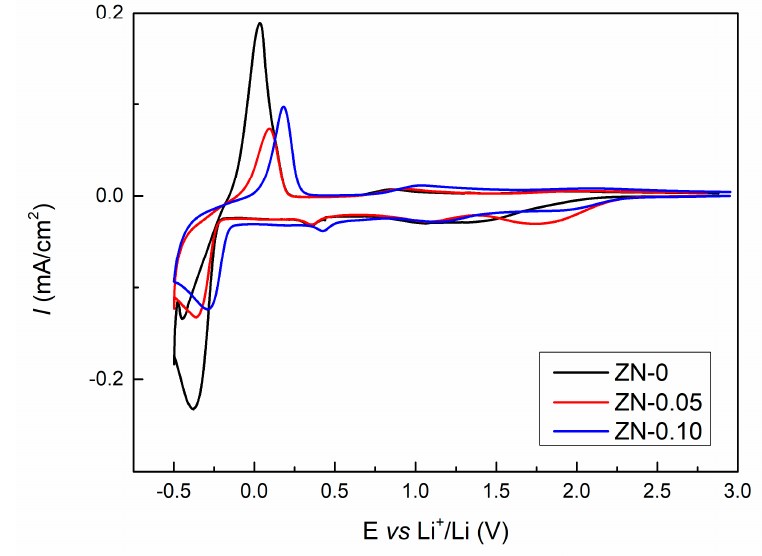
Figure 6. Cyclic voltammograms (first scan) of three-electrode cells with LiTFSI / PEGDM electrolytes containing various amount of ZN zwitterion. Testing conditions: 25 ◦ C; scan rate 1 mV s − 1 ; counter and reference electrodes—Li metal (50 µ m); working electrode—polished stainless steel.